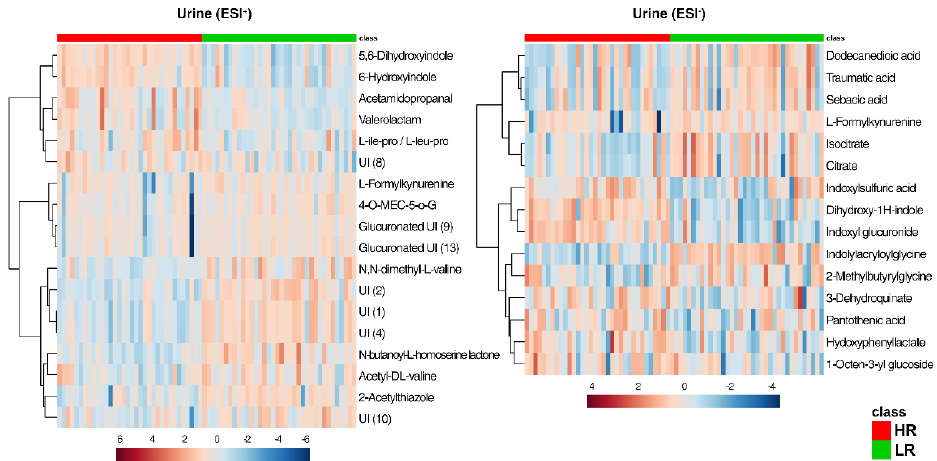
Figure 6. Heat maps of metabolites discriminating ( p < 0.05) between the HR (red class) and the LR (green class) diet in the urine of Göttingen Minipigs in both positive and negative ionization mode (ESI+, ESI − ). Abbreviations: 4-O-MEC-5-O-G, 4-O-methyl-epicatechin-5-O-beta-glucuronide; UI, unidentified compound.